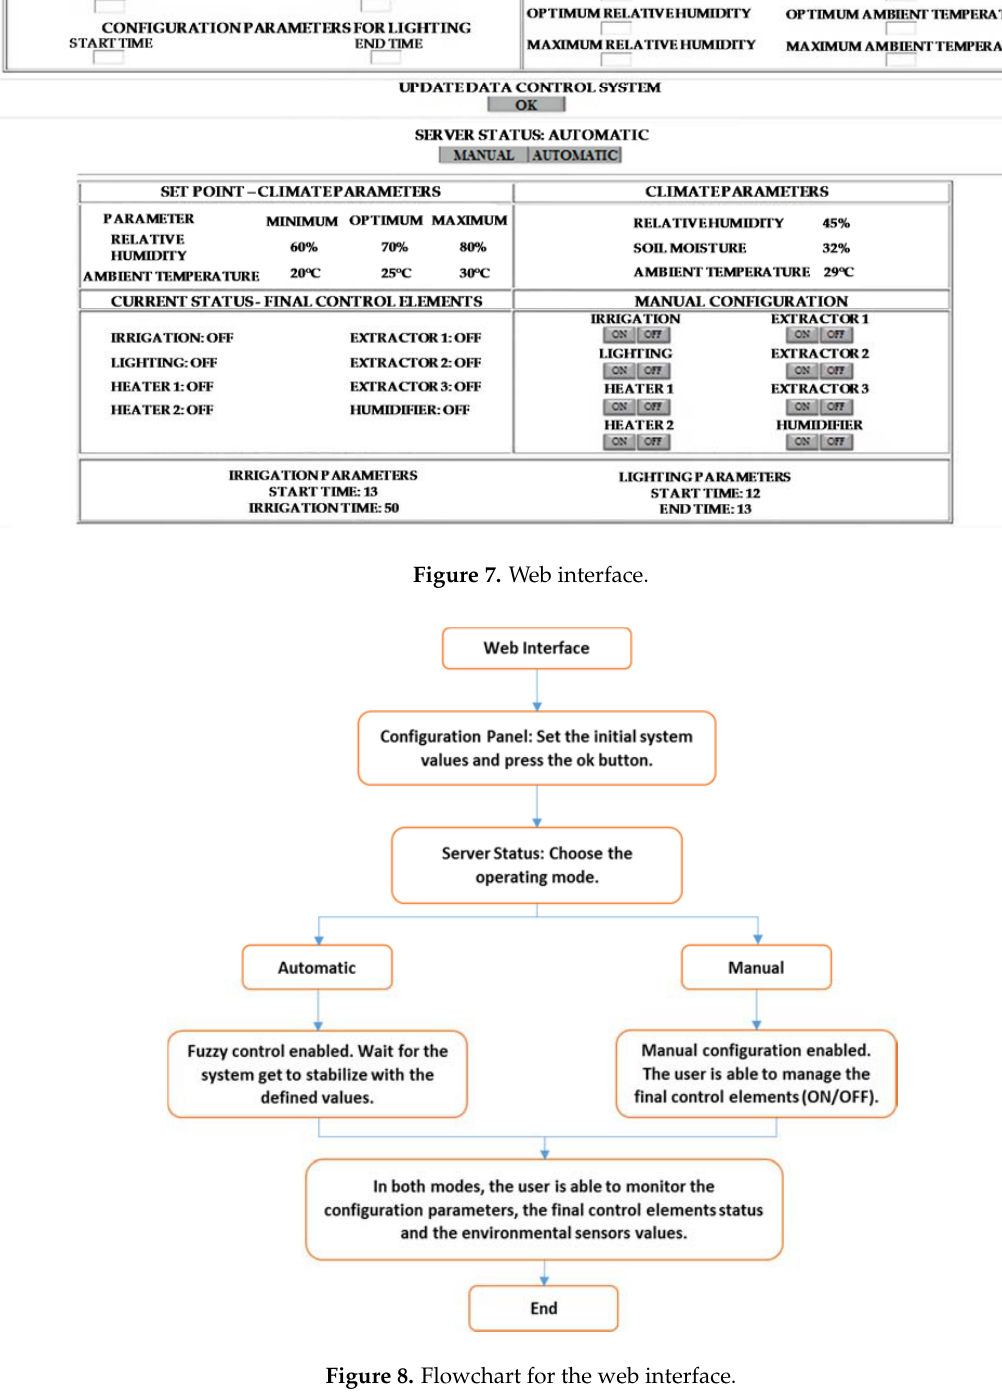
Figure 8. Flowchart for the web interface.